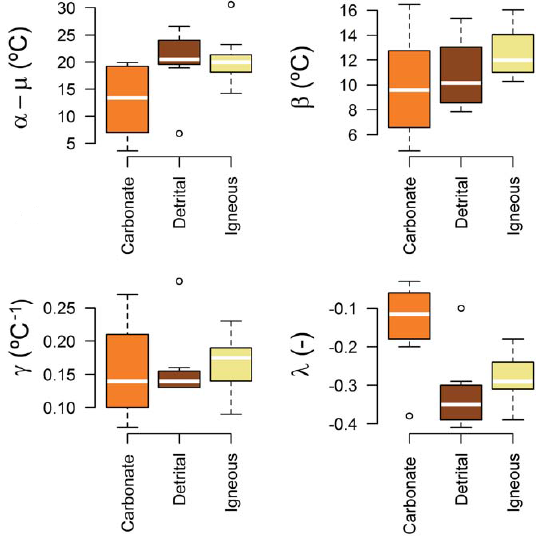
Figure 8. Distributions of the stream temperature model parame- ter values ( α − µ , β , γ and λ) in relation to lithology. Differences were assessed using Student’s t test with the Bonferroni correction ( p